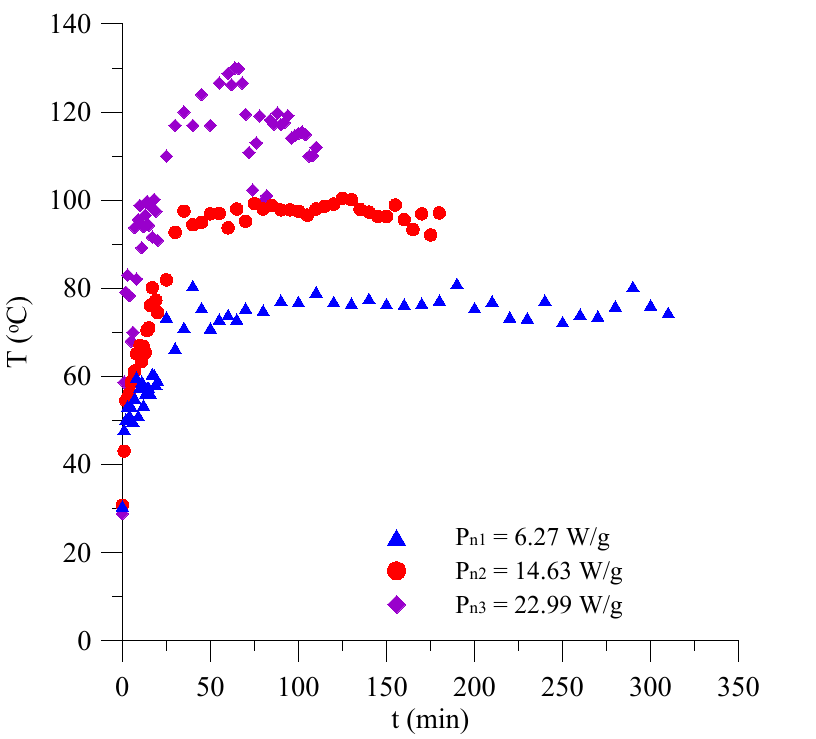
Figure 6. Effect of the supplied microwave power on the surface temperature of paddy rice grains during the drying process.